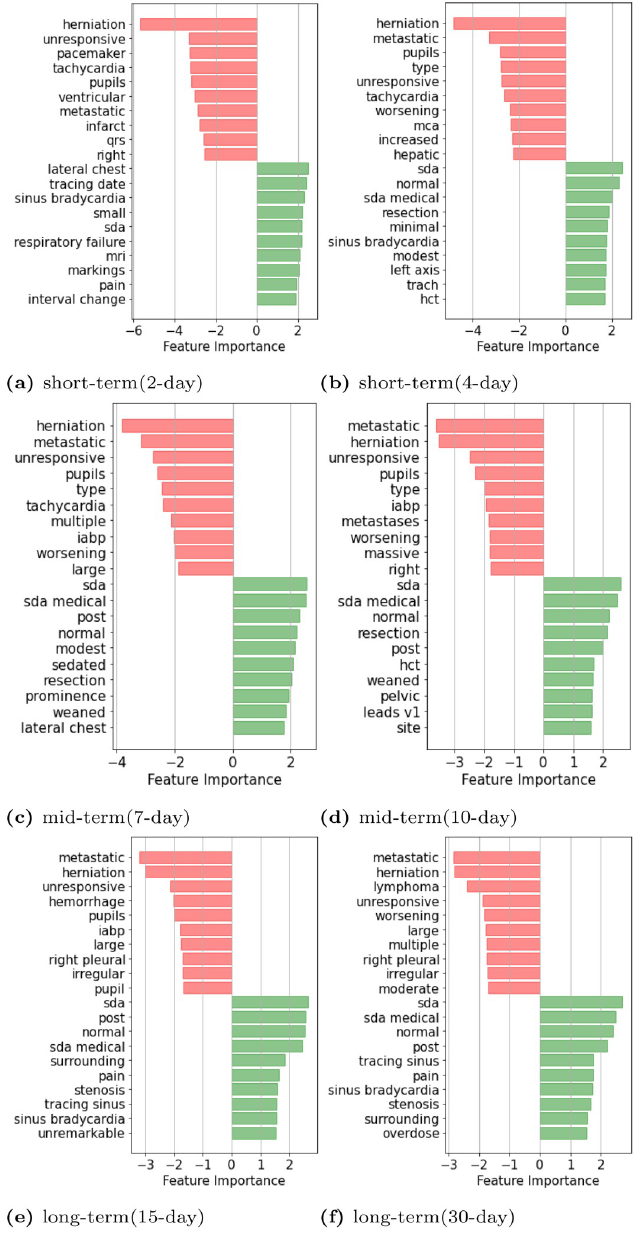
Fig 7. Top 10 most important features that are predictive of the mortality prediction outcome—Alive (green bars), deceased (red bars), by logistic regression model with TF-IDF.